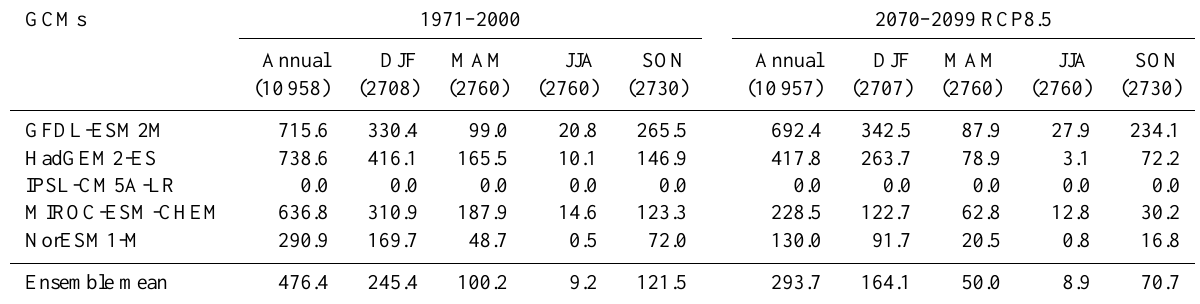
Table 2a. Total number of days when the humidity is oversaturated ( > 100%RH) in the original regridded GCM data. Both the annual and seasonal sums are given as the mean over all land cells (67420 cells). The total numbers of days are given in parentheses in the header.